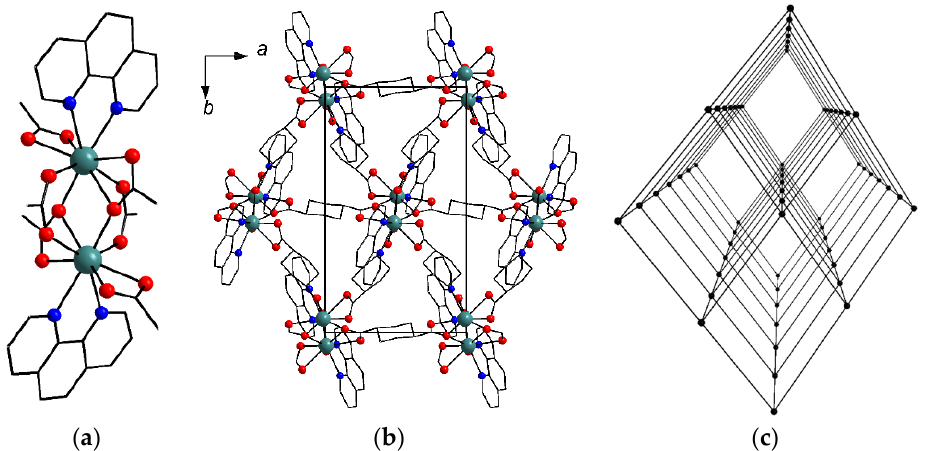
Figure 4. Binuclear block {Nd 2 (phen) 2 (OOCR) 6 } in the structure of 2 Nd ( a ) and view along c crystal- lographic axis ( b ). O atoms are red, N atoms are blue, H atoms and guest molecules are not shown. Topological representation of the coordination lattice in 2 Nd ( c ). Binuclear block {Nd 2 (phen) 2 (OOCR) 6 } is shown as a black node.